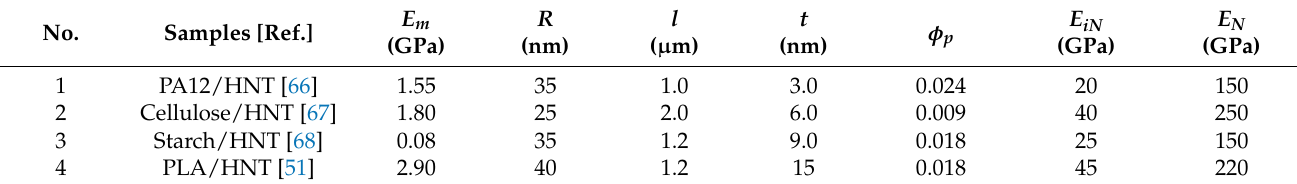
Table 1. Properties for HNT examples and the estimations of developed